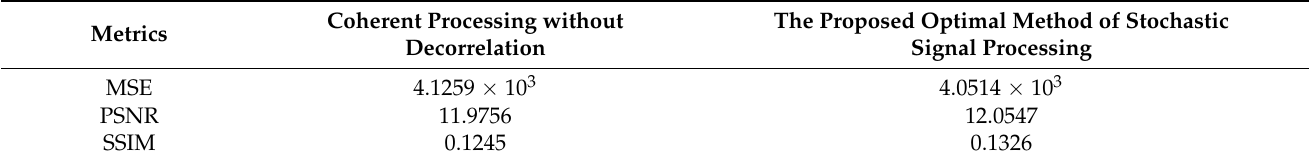
Table 1. Quantitative assessments of the quality of coherent image recovery.